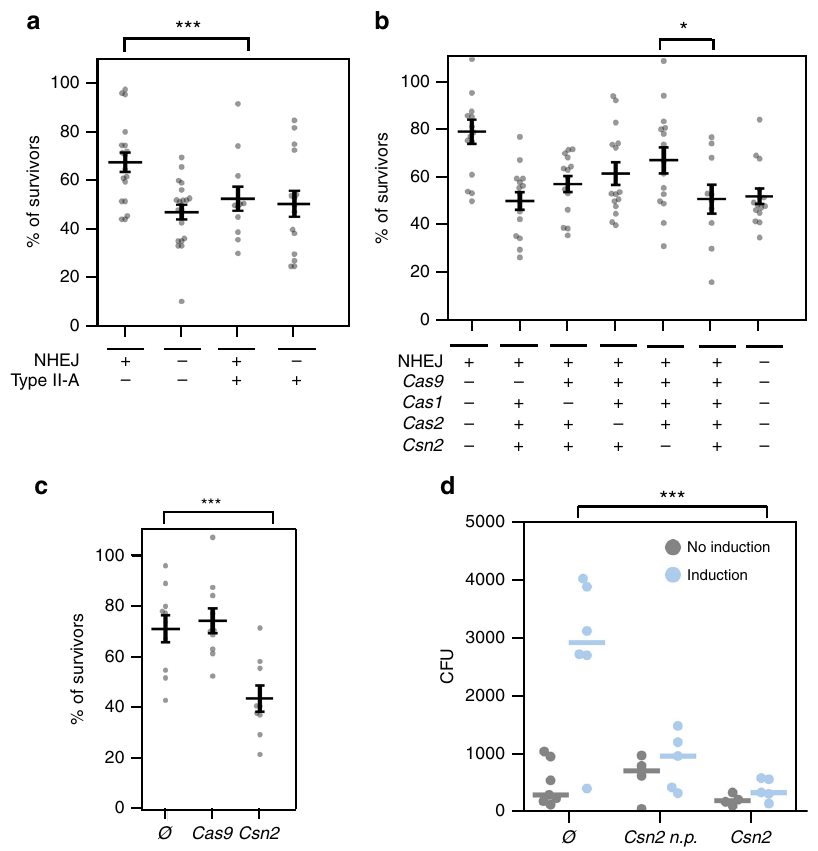
Fig. 4 Csn2 impacts NHEJ repair. Survival rates of irradiated B . subtilis cells. a – c Individual replicates (points) and average (horizontal bars) are shown. Error bars correspond to the standard error of the mean (s.e.m.). a Cells carrying the type II-A CRISPR-Cas system (pRH87) or the control empty vector (pC194), and deleted for ku and ligD or not ( P = 0.0009, Wilcoxon's). b B. subtilis carrying the CRISPR-Cas system with the dCas9 mutations (pRH121) or deleted for csn2 (pRH63), cas1 (pRH61), or cas2 (pRH62) ( P = 0.02, Student's two-sided t test after validation of normality and homoscedasticity). c B. subtilis carrying the empty pC194 plasmid (Ø), expressing csn2 from plasmid pAB56 or cas9 from plasmid pDB114 ( P = 0.0048, Wilcoxon's). d A linearized plasmid providing resistance to chloramphenicol (pC194) was electroporated into S. aureus RN4220 cells carrying the NHEJ system either alone (plasmid pAB1, Ø) or with csn2 cloned downstream of ligD (plasmid pAB81, csn2) or under the control of its natural promoter (plasmid pAB82, csn2 n.p.). The number of CFUs obtained with or without induction of the NHEJ system using aTc are reported. The number of CFU obtained without induction (gray bars) indicate the background of already circular DNA present in the sample before electroporation ( P = 0.006, two-sided t